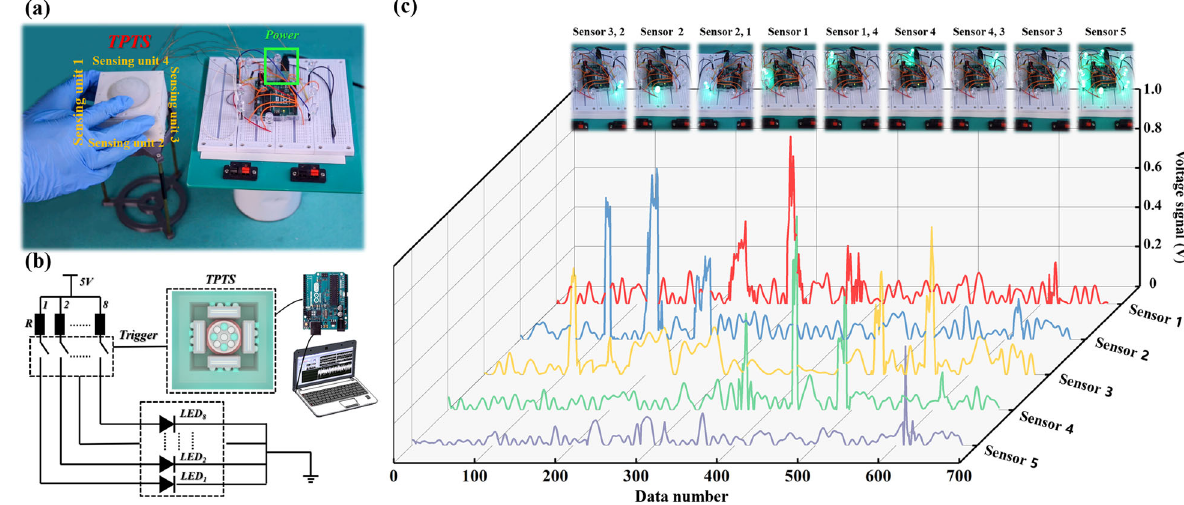
Fig. 5 Experiments with TPTS controlling LED lights. a Experimental electronic setup. b Electronic module used for potential application demonstrations, such as controlling LED lights. c Demonstration of TPTS as a sensitive load switch control and its corresponding output voltage